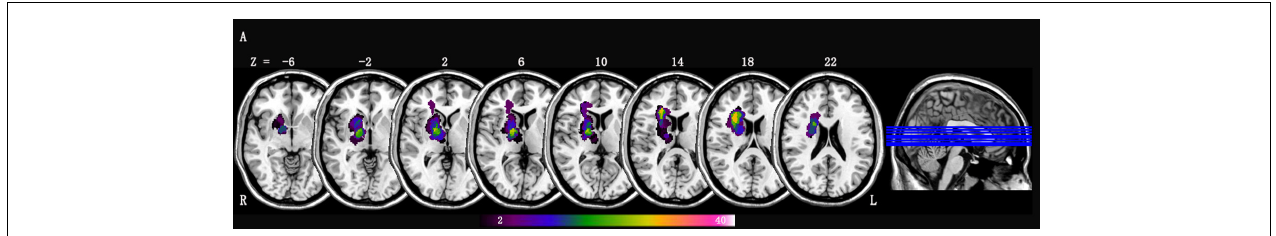
FIGURE 1 | Lesion overlap map across stroke patients with right-sided lesions ( n = 42); Lesion maps were normalized to an MNI reference brain. The color bar indicates the percentage of lesion overlap.